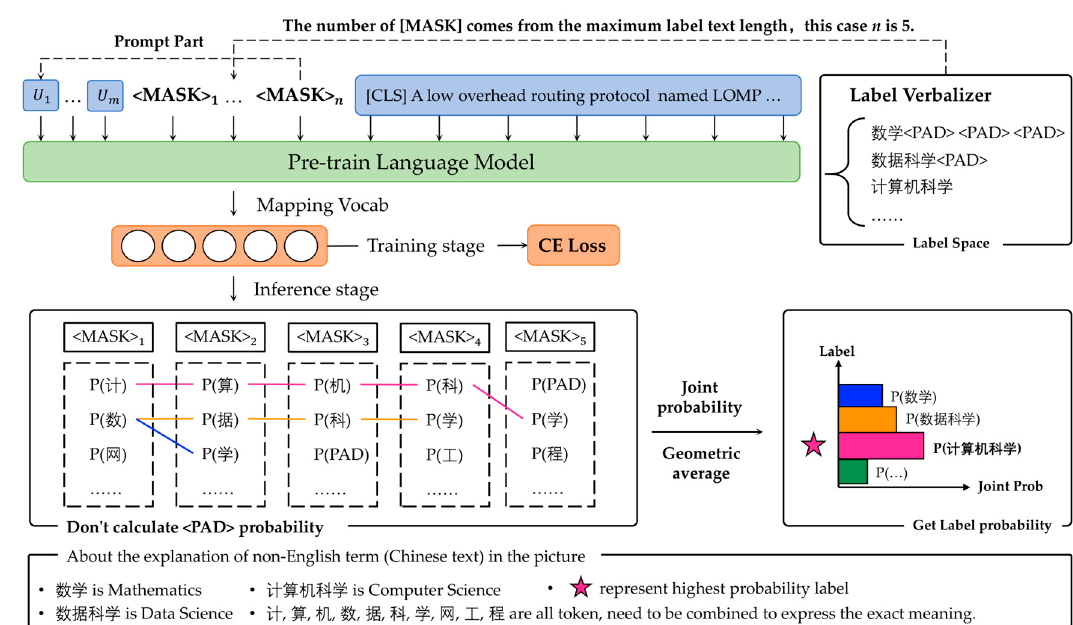
Figure 1. The few-shot text classification model is constructed through the Multiple Masks Optimization-based Prompt Learning module. The rose star symbol ( ★ ) in the image represents the label with the highest probability of scoring among all the labels predicted by the model.